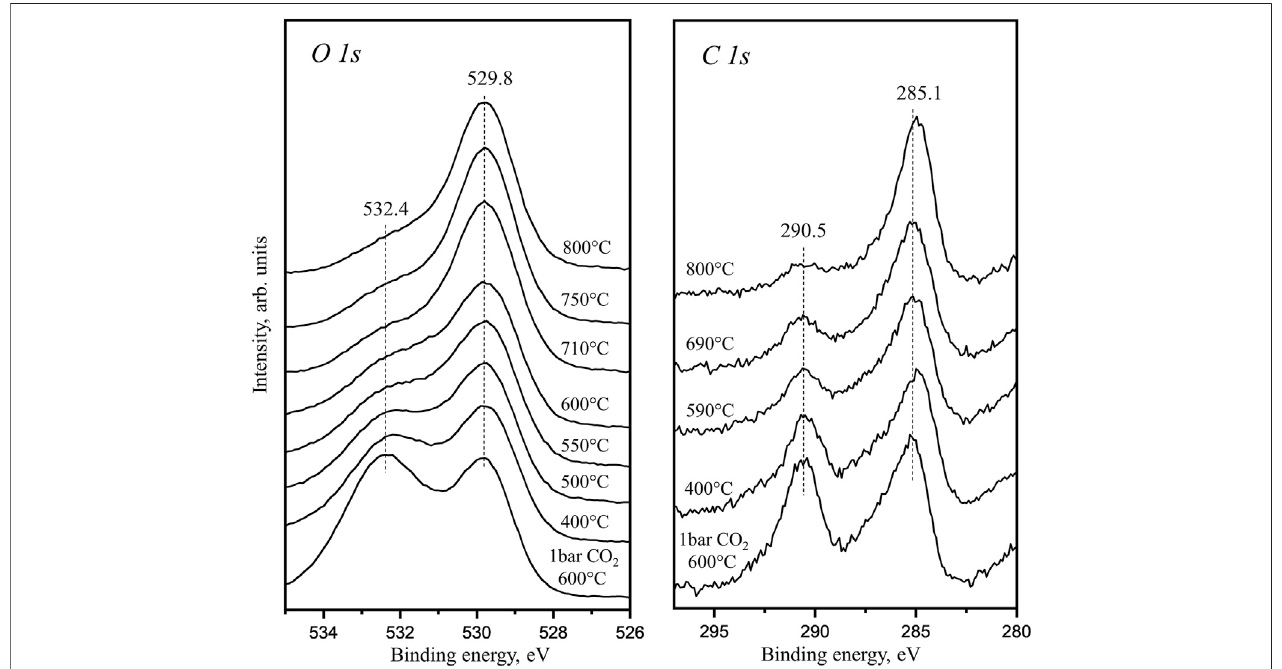
FIGURE 1 | In situ XPS C 1s and O 1s core level spectra obtained in the temperature range from 400 to 800 ° C after pretreatment under 1 bar CO connected